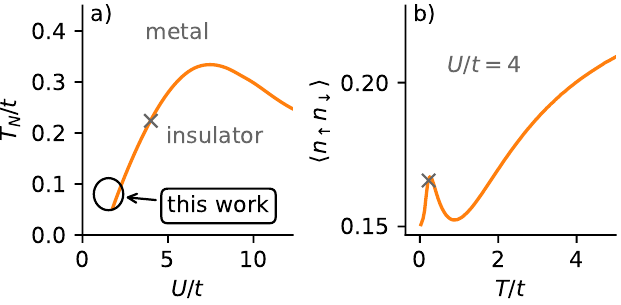
Figure 1: a) Sketch of the Néel temperature in the Hubbard model from CDMFT cal- culations in Ref. [ 31 ] . The regime studied here is highlighted. b) Double occupancy versus temperature in the Slater regime from Ref. [ 12 ] . The maximum is close to the Néel temperature